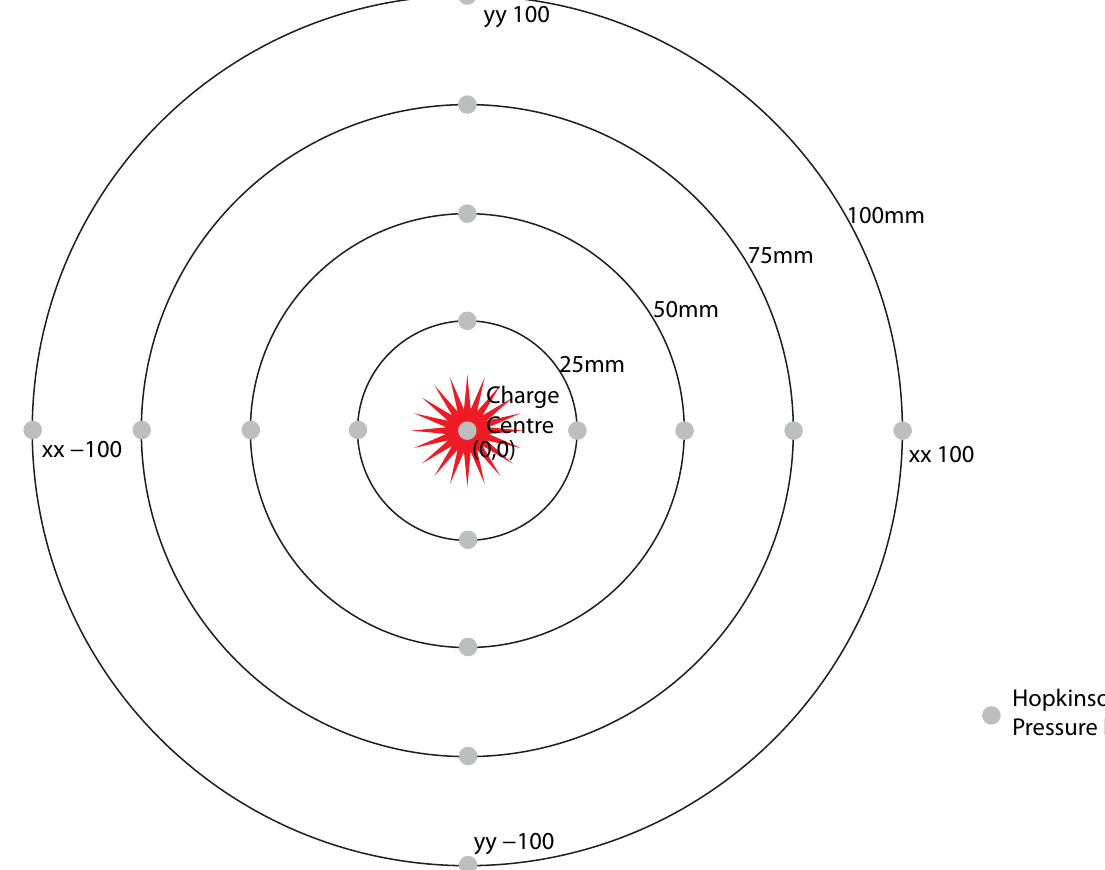
Figure 3. Layout of HPBs in the rigid target plate for the CoBL experimental